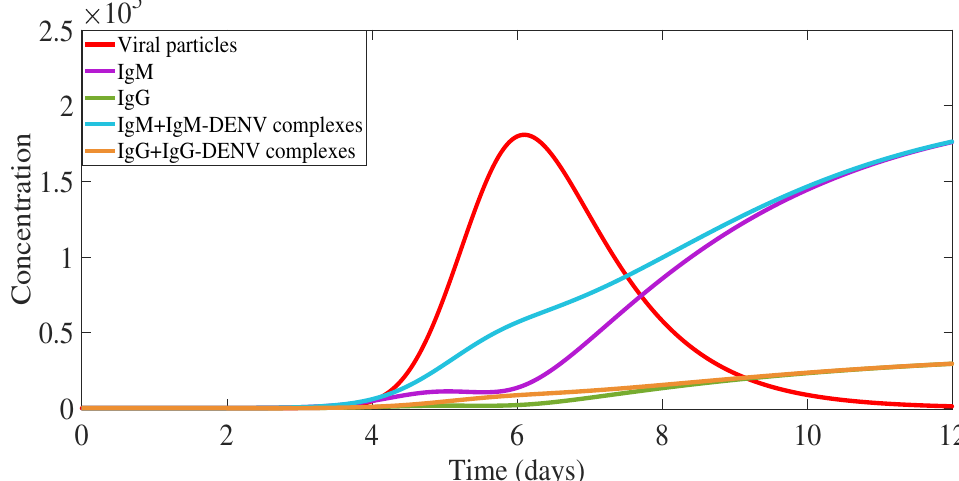
Figure 5. Model simulation: primary dengue infection immunological responses mediated by antibodies. Overall viral particles measured with free virus and viral particles in complexes ( V + 4 · IgM-DENV + IgG-DENV). Free IgM is shown in violet and free IgG in green. Antibodies-virus complexes IgM-DENV and IgG-DENV are shown in blue and orange, respectively, with initial values C M ( t 0 ) = 0 and C G ( t 0 ) =